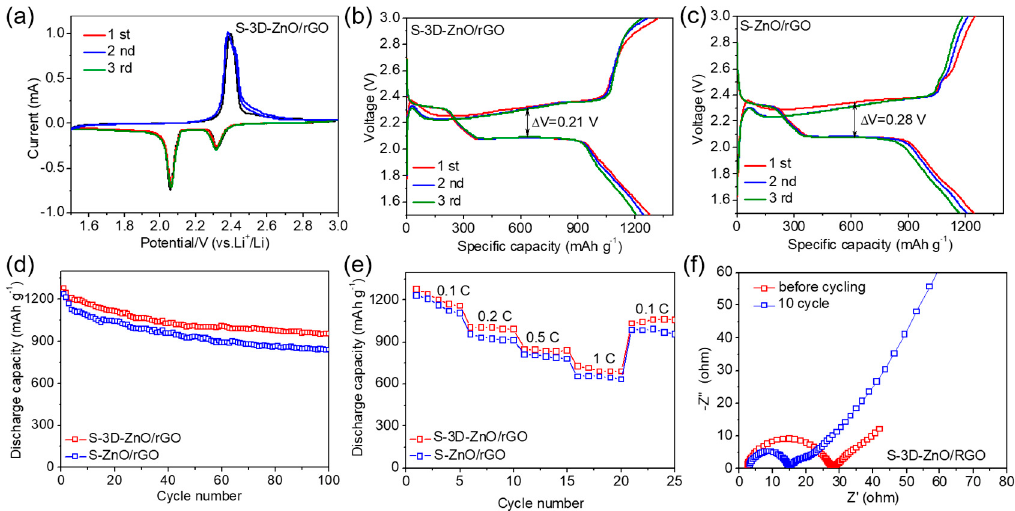
Figure 9. ( a ) CV curves of S-3D-ZnO / rGO composite cathode. Constant current charge and discharge curves of ( b ) S-3D-ZnO / rGO and ( c ) S-ZnO / rGO composites at 0.1 C. ( d ) Cycling performance of S-3D-ZnO / rGO and S-ZnO / rGO composite cathodes at 0.1 C. ( e ) Rate performance of S-3D-ZnO / rGO and S-ZnO / rGO composite cathodes. ( f ) EIS spectra of S-3D-ZnO / rGO composite cathode before cycling and at 10th